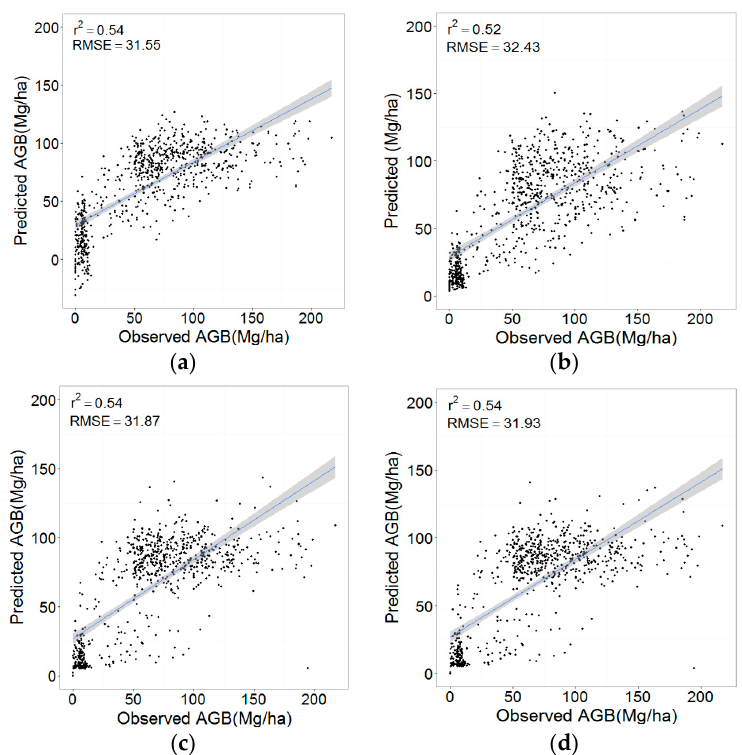
Figure 4. Predicted vs. observed (that is, referenced) AGB of sample plots using: ( a ) the multivariate linear regression (MLR); ( b ) the logistic regression (LR); ( c ) g-kNN with k = 10 nearest neighbors; and ( d ) CW-kNN with k = 10 nearest neighbors.